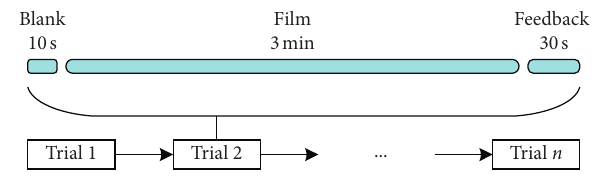
Figure 2: Emotional induction experimental